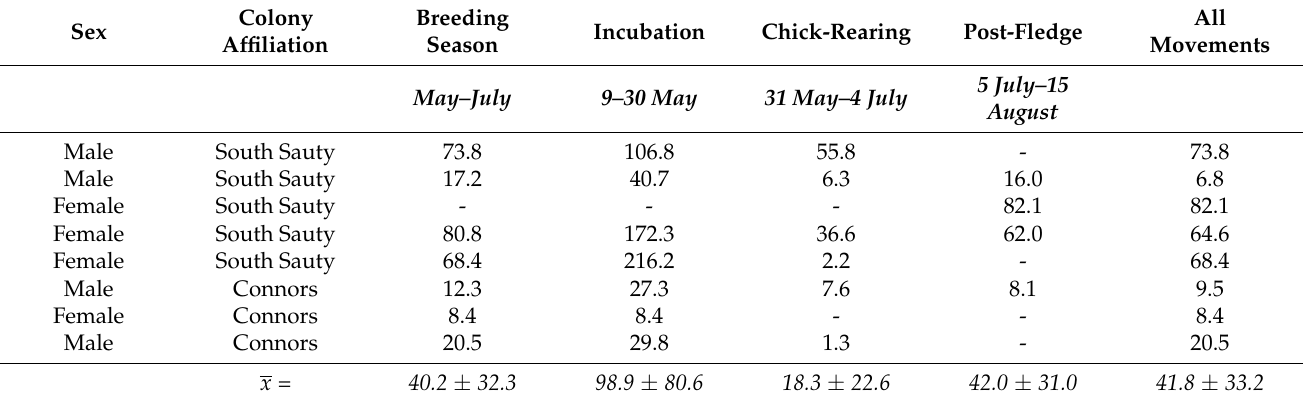
Table 1. Ninety-five percent home ranges (km 2 ) measured for all movements of Double-crested Cormorants ( n = 8 birds) on Guntersville Reservoir, Alabama in 2017. Breeding season ( n = 7) is incubation ( n = 6) and chick-rearing periods ( n = 6), combined. Post-fledge ( n = 4), colony affiliation refers to a nesting site. Dashes indicate no data for that time period.